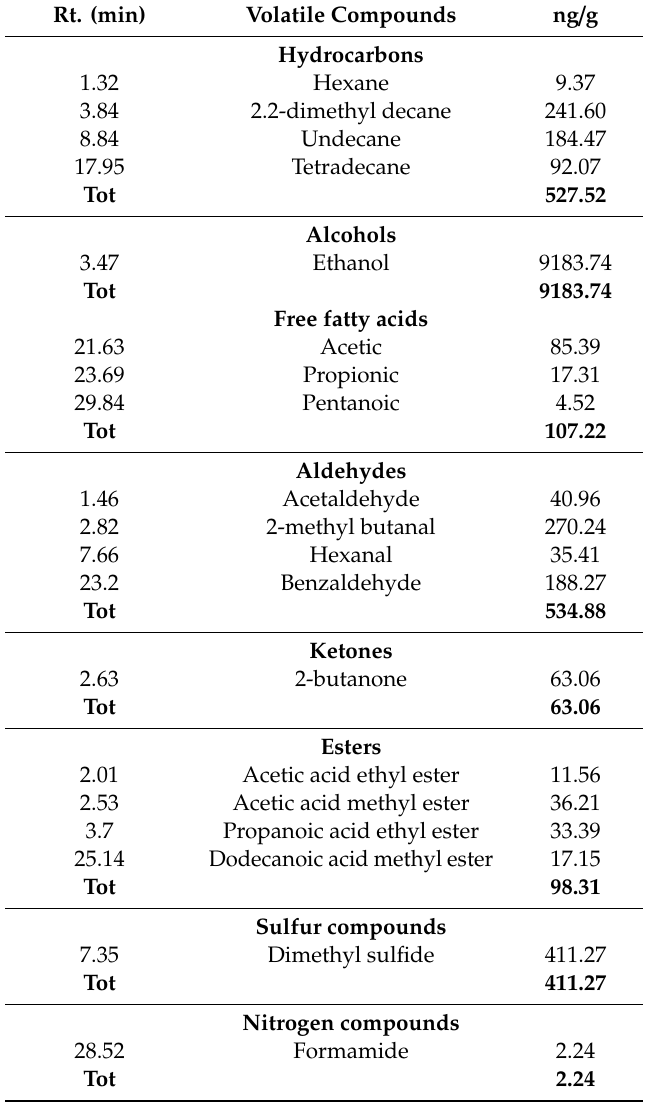
Table 4. Volatile compound profile of sterilized defatted earthworm